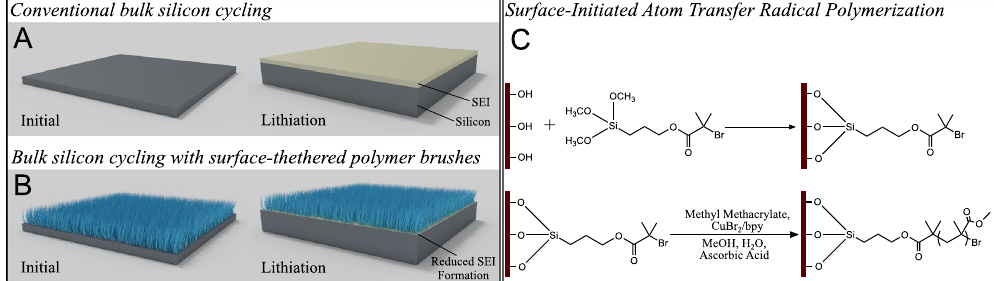
Figure 1. ( A ) Cartoon representation of bare bulk silicon (grey) thin films. The solid electrolyte interface (SEI, yellow) develops on the silicon surface during initial cycling. ( B ) Cartoon representation of cycling of bulk silicon functionalized with surface-tethered polymer brushes. Silicon surface passivation is enhanced, reducing the amount of SEI formed on the surface. ( C ) ATRP reaction scheme used to graft polymer chains to the silicon